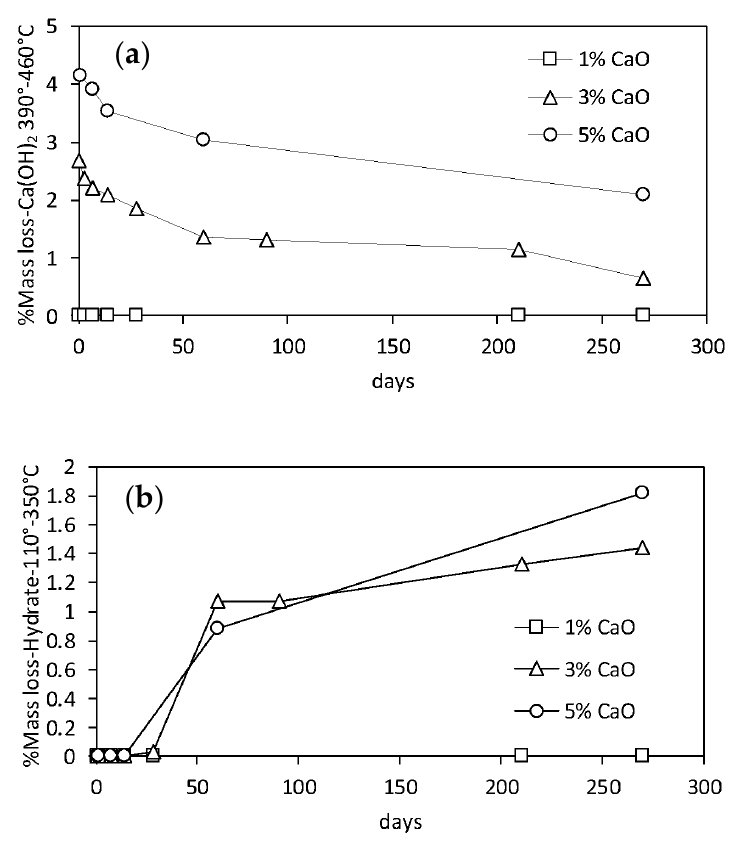
Figure 7. Quantitative interpretation of the thermogravimetric analyses on treated kaolin at increasing lime contents: ( a ) portlandite consumption; ( b ) development of hydrated